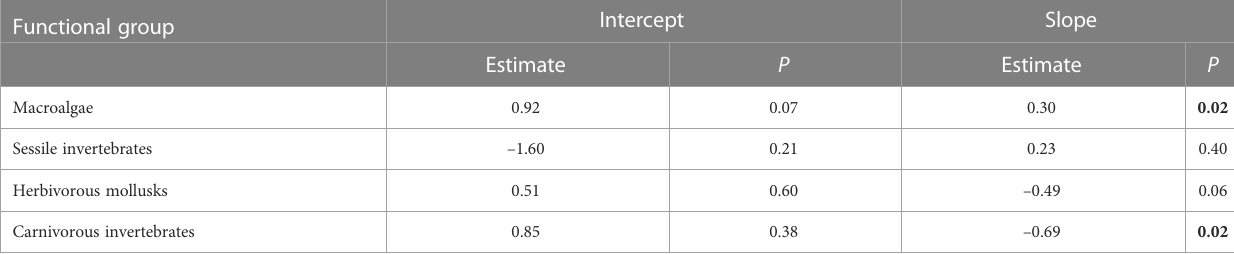
TABLE 3 Accumulative carryover effects on community abundances of four functional groups of rocky intertidal organisms in southeast Hokkaido, Japan. Functional